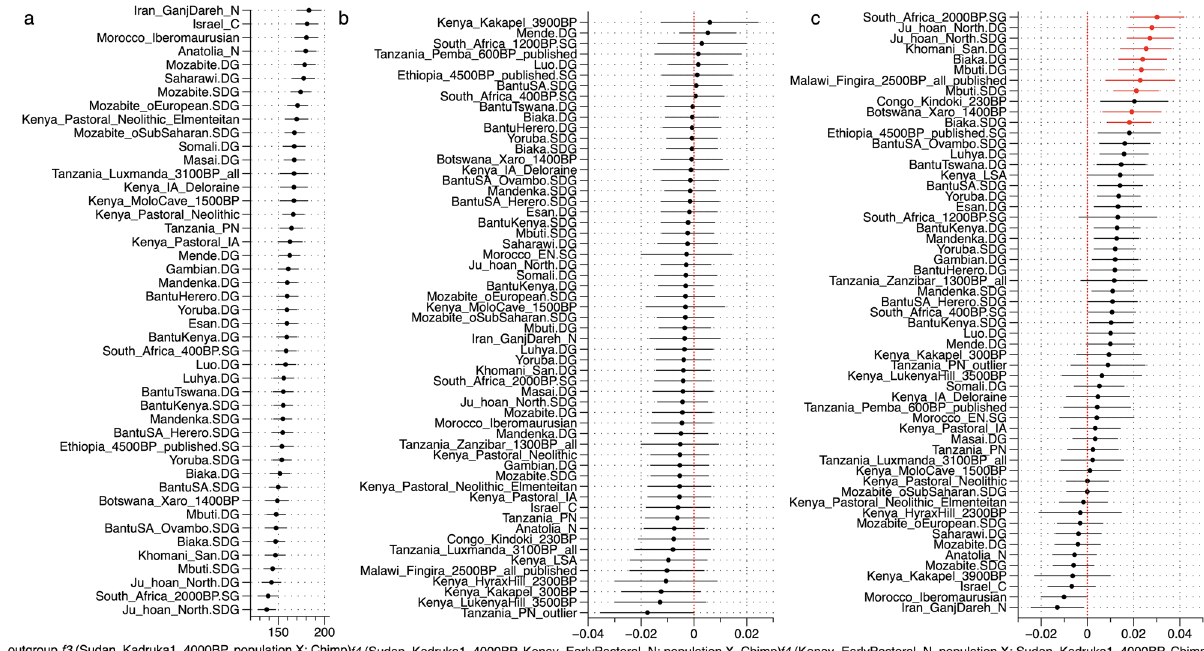
Figure 4. Genetic affinity with ancient African pastoralists. ( a ) Outgroup f3 (Sudan_Kadruka1_4000BP, population X; Chimp). ( b ) f4 (Sudan_Kadruka1_4000BP, Kenya_EarlyPastoral_N; population X, Chimp). ( c ) f4 (Kenya_EarlyPastoral_N, population X; Sudan_Kadruka1_4000BP, Chimp). Population X includes published ancient African and Near Eastern populations and modern African populations from SGDP and HGDP data sets (Table S3). We plot two standard error bars for f3 and f4 statistics shown here and highlight statistically significant tests (Z-score > 3) in red